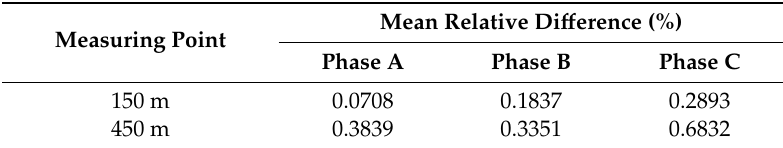
Table 2. Mean relative difference of transient voltage in example 3.1.